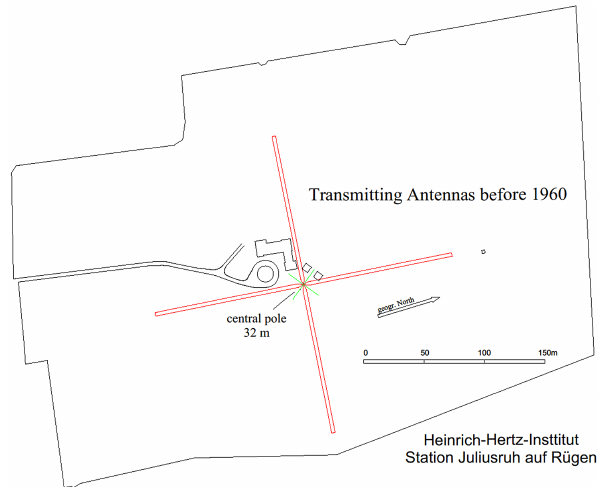
Figure 15. Grounds of the Juliusruh station with the broadband antennas. The two small squares in the middle indicate the wooden cottages from the founding year. The main building was established in 1957.